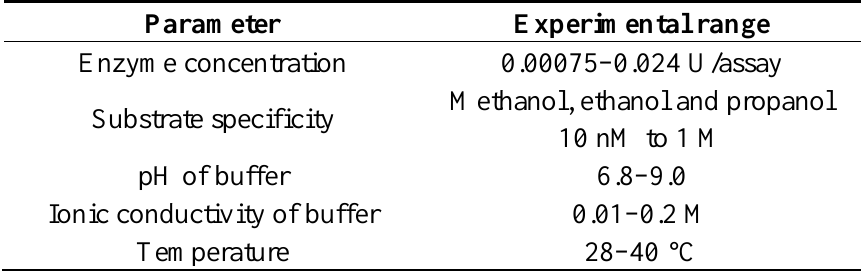
Table 1 . Optimization of experimental parameters in 96 well plate